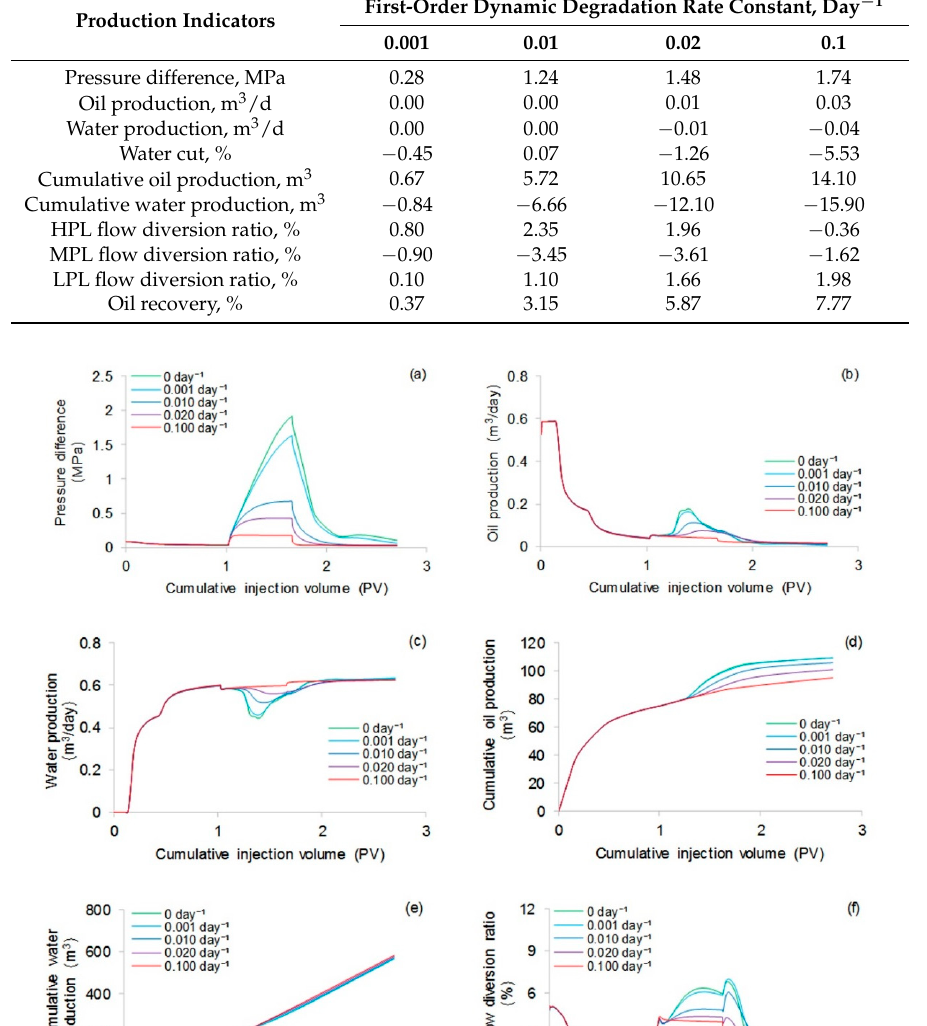
Table 7. Reduction in production indicators caused by different first-order dynamic degradation rate constants after cumulative injection volume of 1.67 PV.